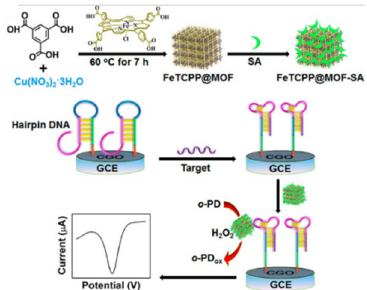
Figure 8. Schematic illustration of the synthesis of an FeTCPP@MOF − SA composite and electrochemical DNA sensing via the allosteric switch of hairpin DNA. Reprinted with permission from Ref. [210]. Copyright 2015, American Chemical Society.